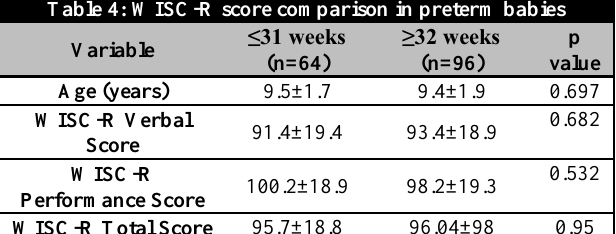
Table 4: WISC-R score comparison in preterm babies